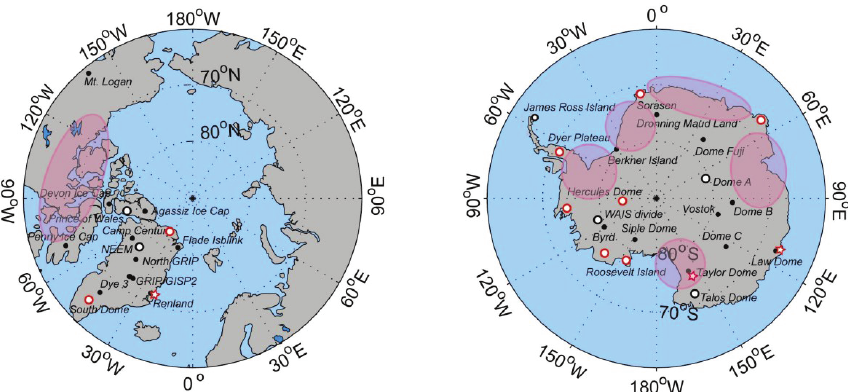
Fig. 1. Greenland and Antarctic deep drilling sites synthesised for the International Partnership for Ice Core Science (from http://www.